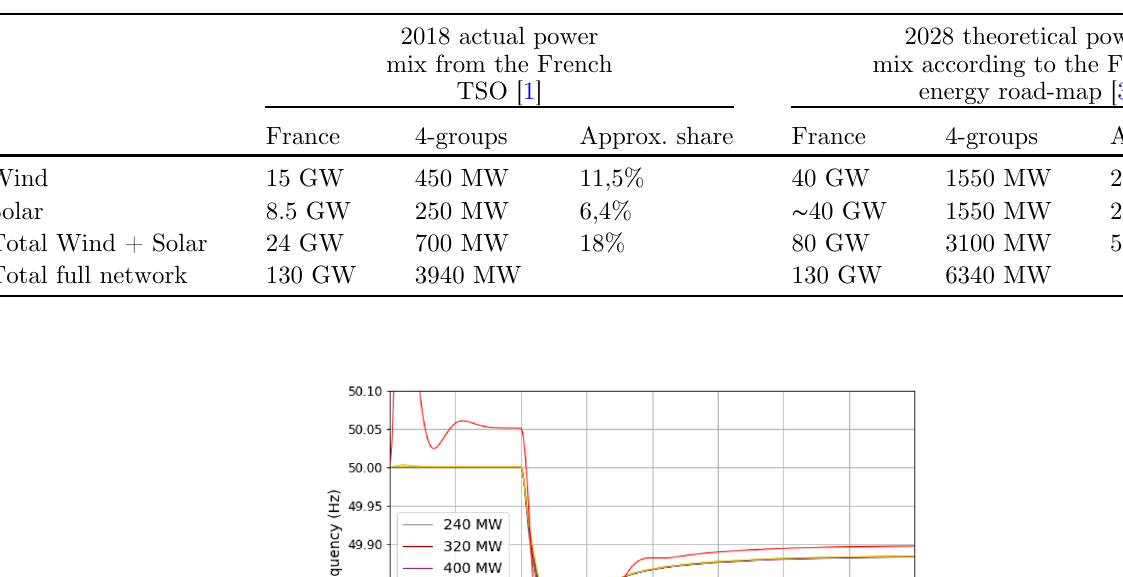
Table 4. Projection of installed capacities of wind and solar power plants in 2018 and 2028 for France and the “ 4-groups ” equivalent model.